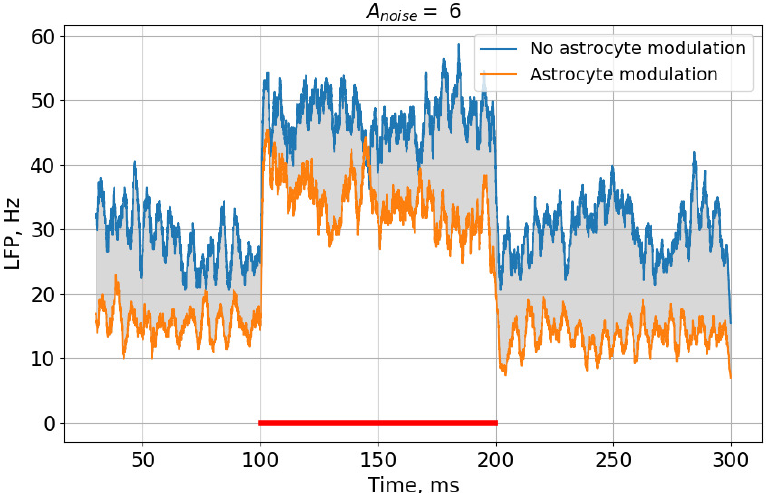
Figure 7. Comparison of the regulation of neuronal activity in the absence and presence of astrocytic modulation for a LFP signal with a noise current amplitude, A noise = 6. The red line indicates the time of feeding the image to the neural